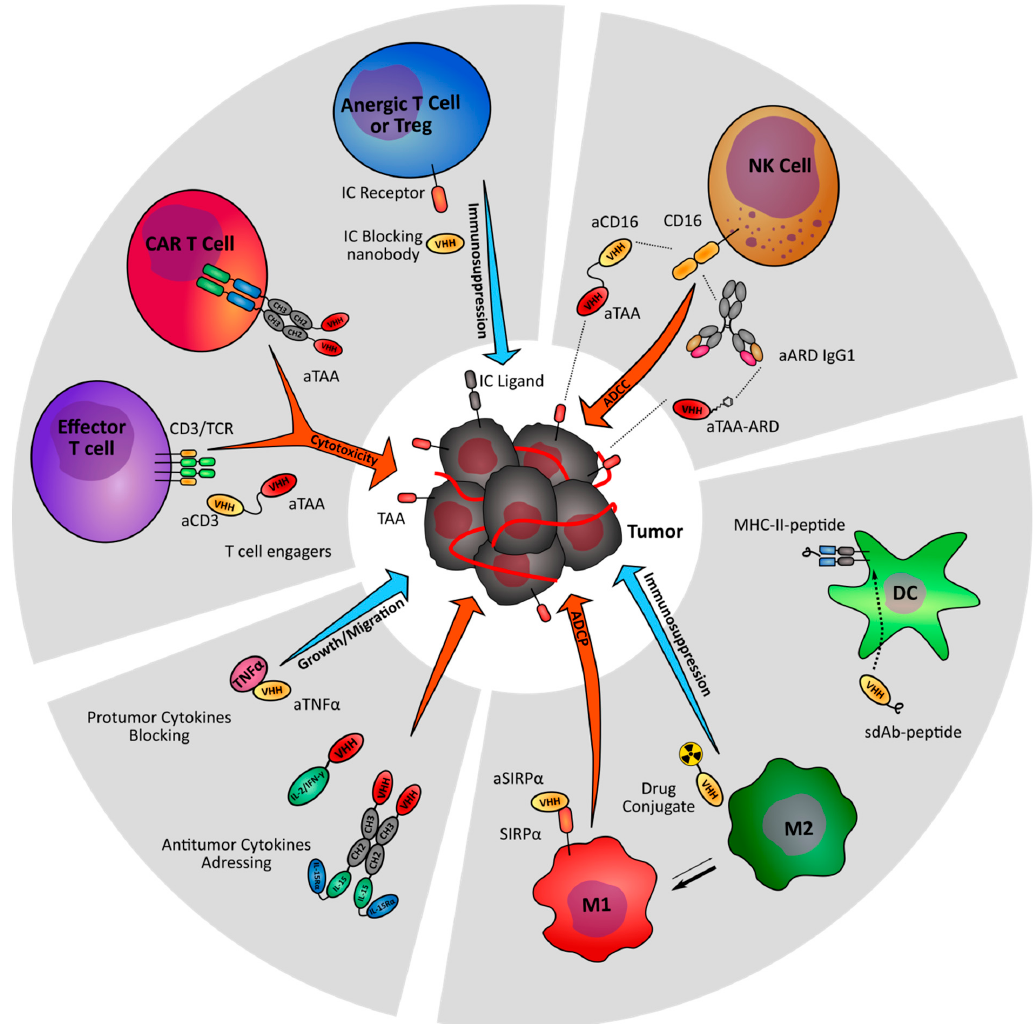
Figure 2. Nanobody-based strategies targeting the immune stroma of tumors. Nanobody-derived immunomodulatory molecules are under investigation to increase anti-tumor immunity (orange arrows) and prevent tumor-driven immune suppression (blue arrows). TAA: Tumor associated antigen; IC: Immune checkpoint; ARD: Antibody recruiting domain.